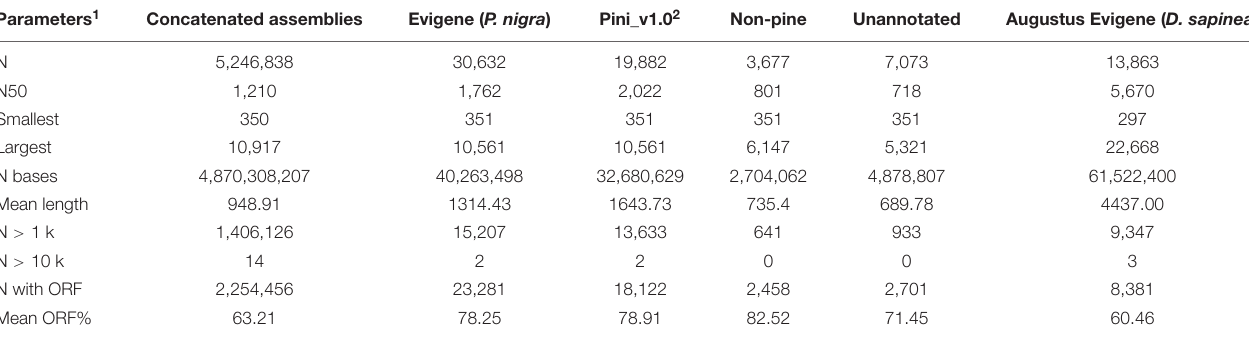
TABLE 1 | Summary of assembly statistics.